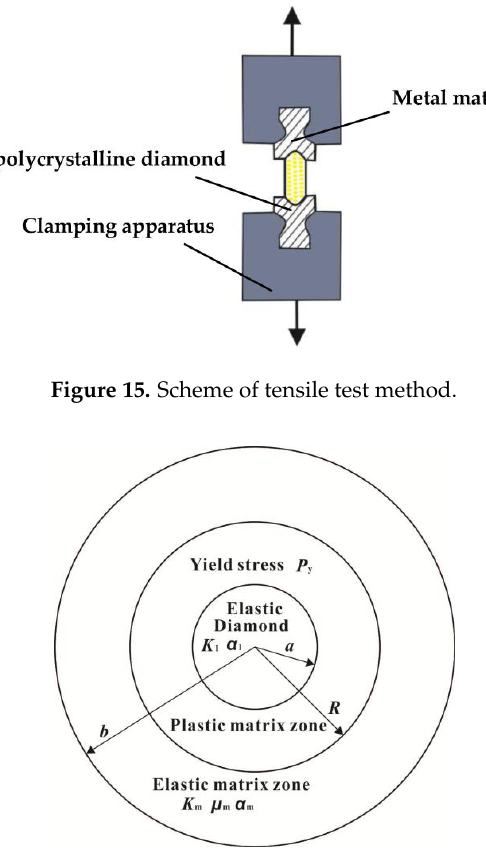
Figure 14. Scheme of compression test method.